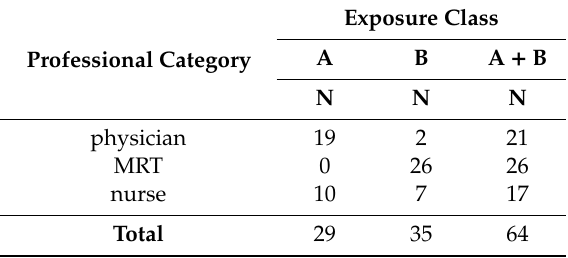
Table 4. Number (N) of respondents in each exposure and professional categories.